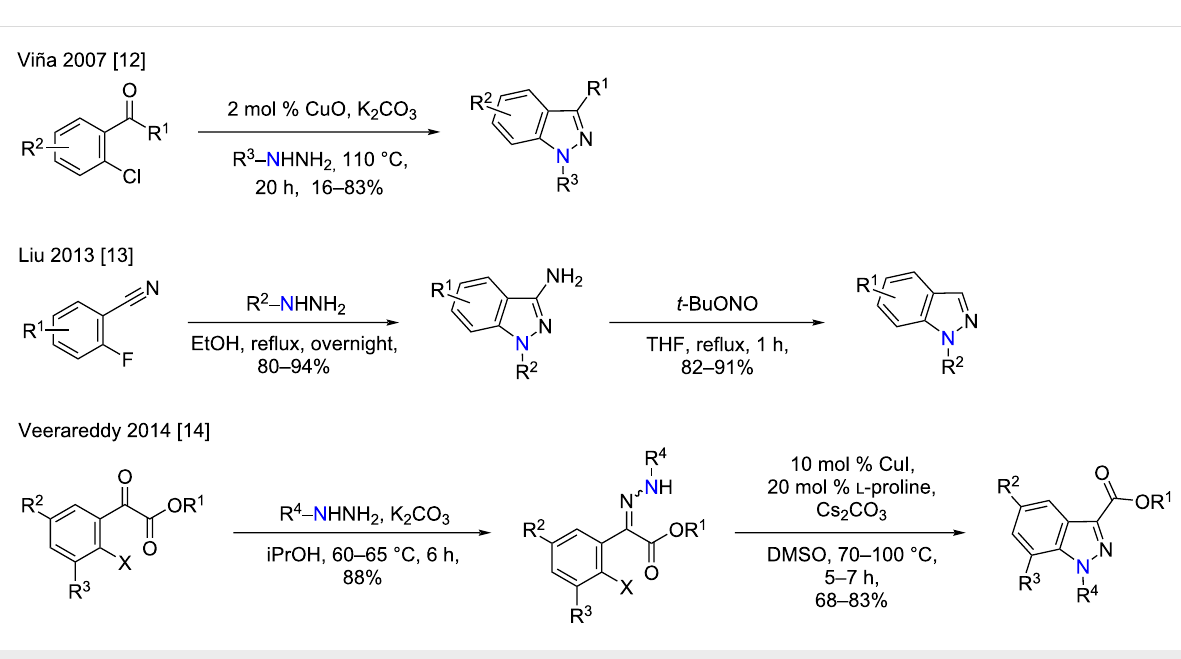
Scheme 1: Synthetic approaches to N -1 substituted indazole derivatives